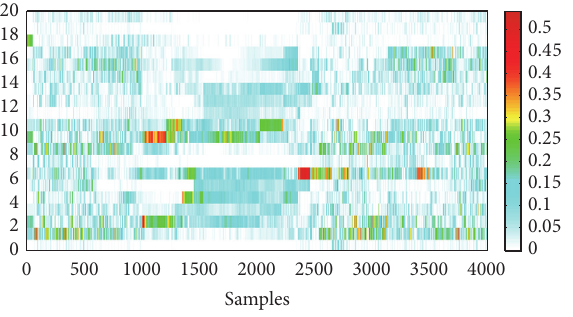
Figure 10: Diagnosis result of fault